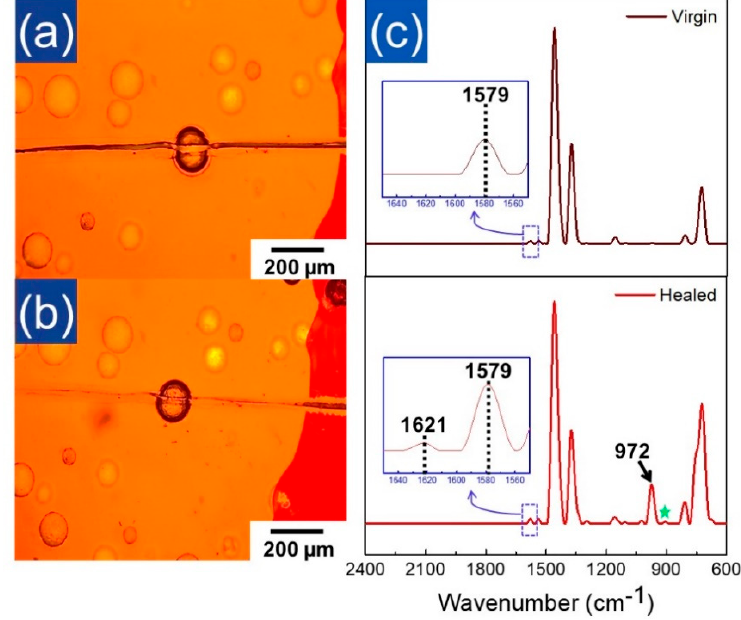
Figure 5. Optical microscopy images of the EPDM/microcapsule rubber composites with 10 wt% of the mechanically-enhanced microcapsules ( a ) right after being scratched with a razor blade and ( b ) after 5 h following scratching. ( c ) Normalized ATR FT-IR spectra of the neat EPDM rubber (top) and the healed EPDM/microcapsule rubber composite (bottom). ATR FT-IR spectrum of the healed EPDM/microcapsule rubber composite measured at the damaged crack region after 5 h following scratching with razor blade.